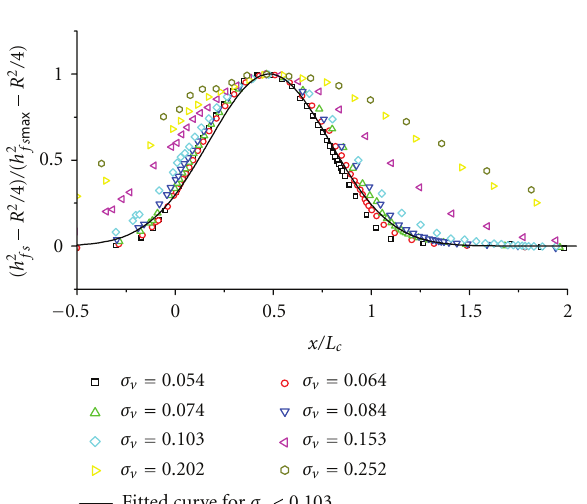
Figure 6: Universal profiles of the free surface at di ff erent σ v , h/H = 0 . 75. Table 2: Parameters for fitted curves of the upper surface of the